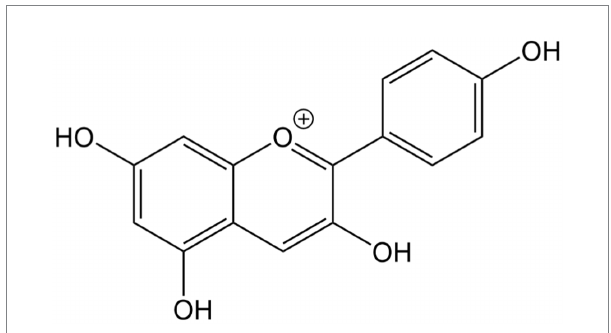
FIGURE 12 Chemical structure of anthocyanins